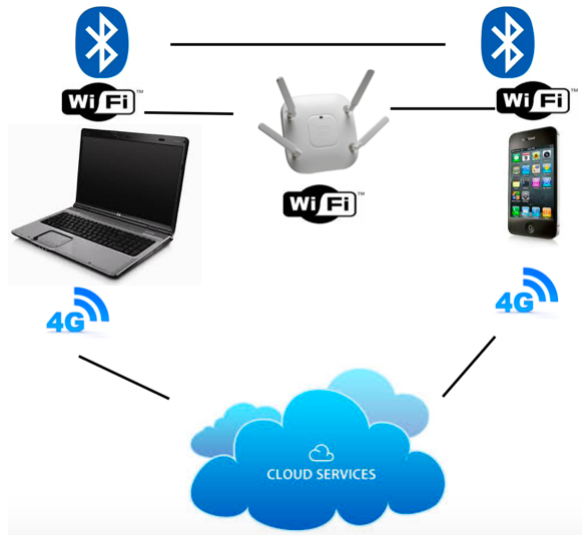
Figure 5. Bluetooth, WiFi and 4G architecture.